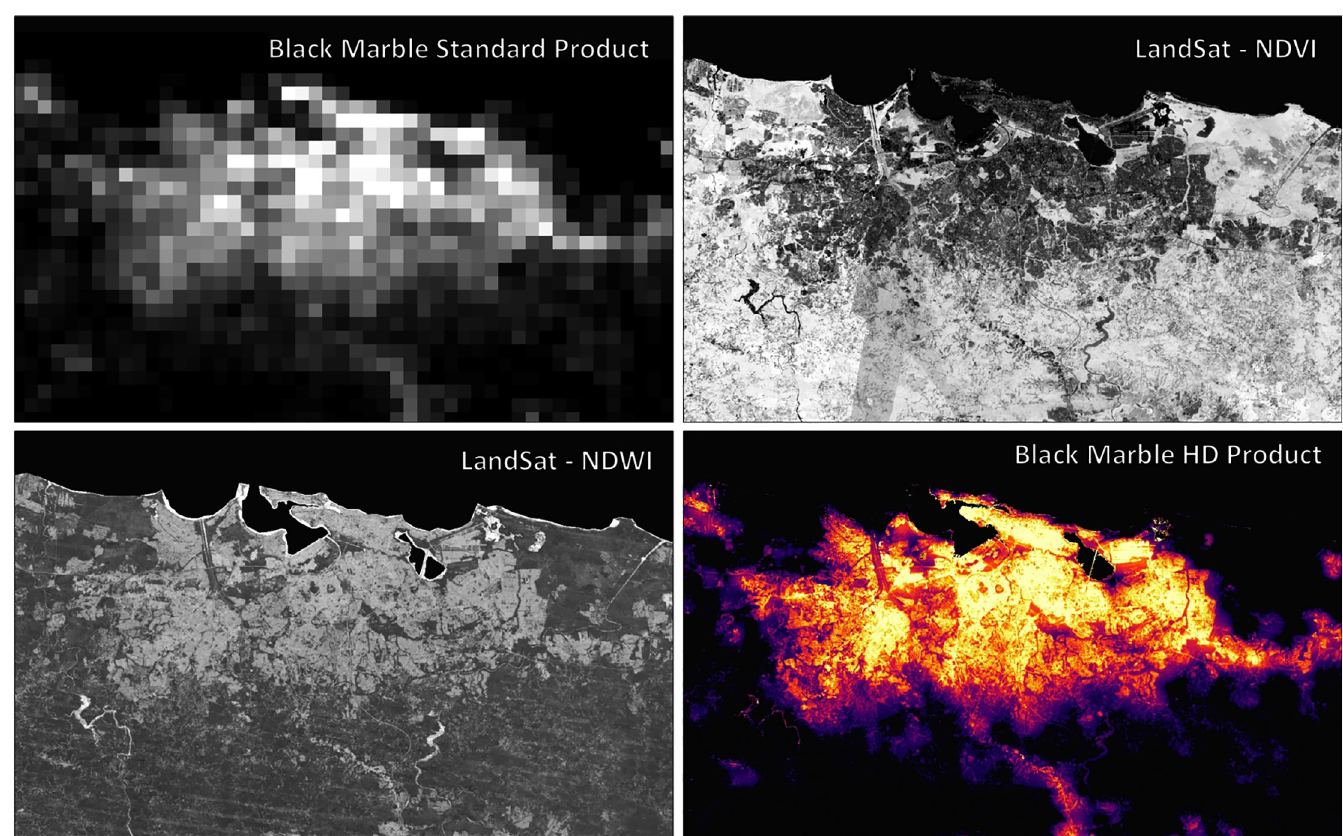
Fig 1. Data inputs for the production of the Black Marble HD Product to measure Puerto Rico neighborhood level electricity access. (Top right) 500m Black Marble VNP46 product (Top left) Landsat 8/Sentinel 2 NDVI (Bottom left) Landsat 8/ Sentinel 2 NDWI (Bottom right) Black Marble HD 30m Product.